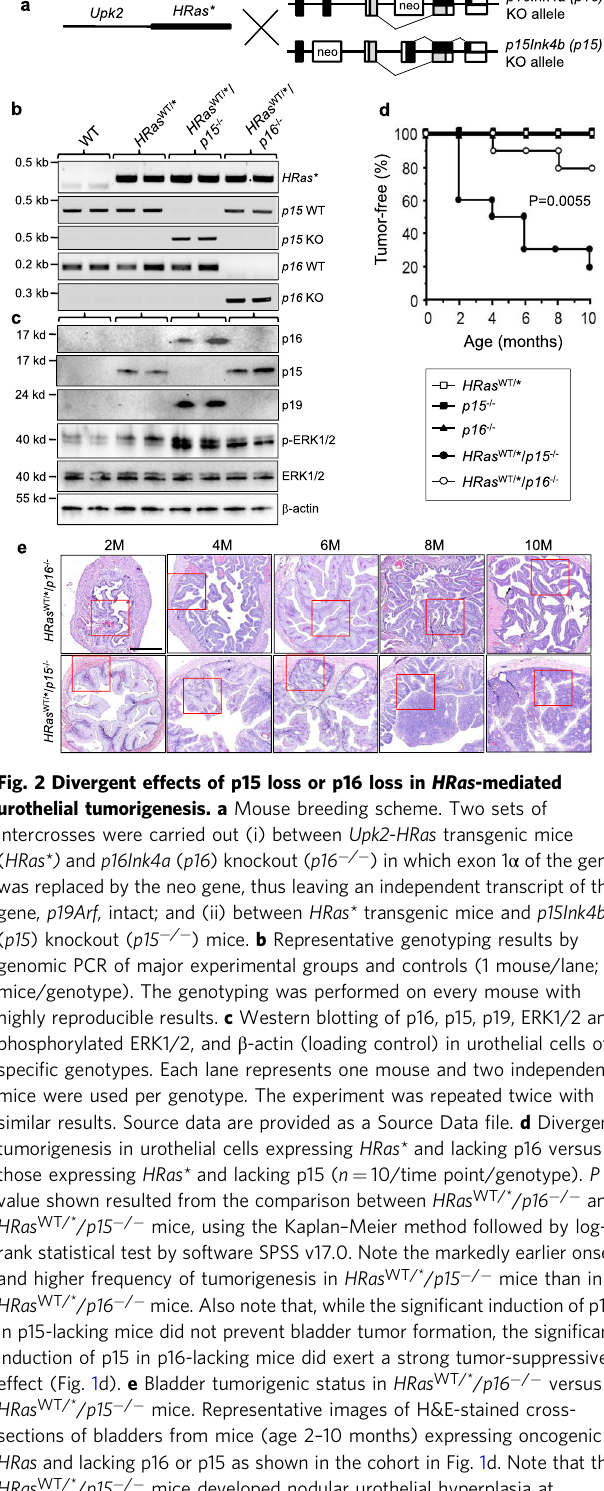
speci fi c genotypes. Each lane represents one mouse and two independent mice were used per genotype. The experiment was repeated twice with similar results. Source data are provided as a Source Data fi le. d Divergent tumorigenesis in urothelial cells expressing HRas* and lacking p16